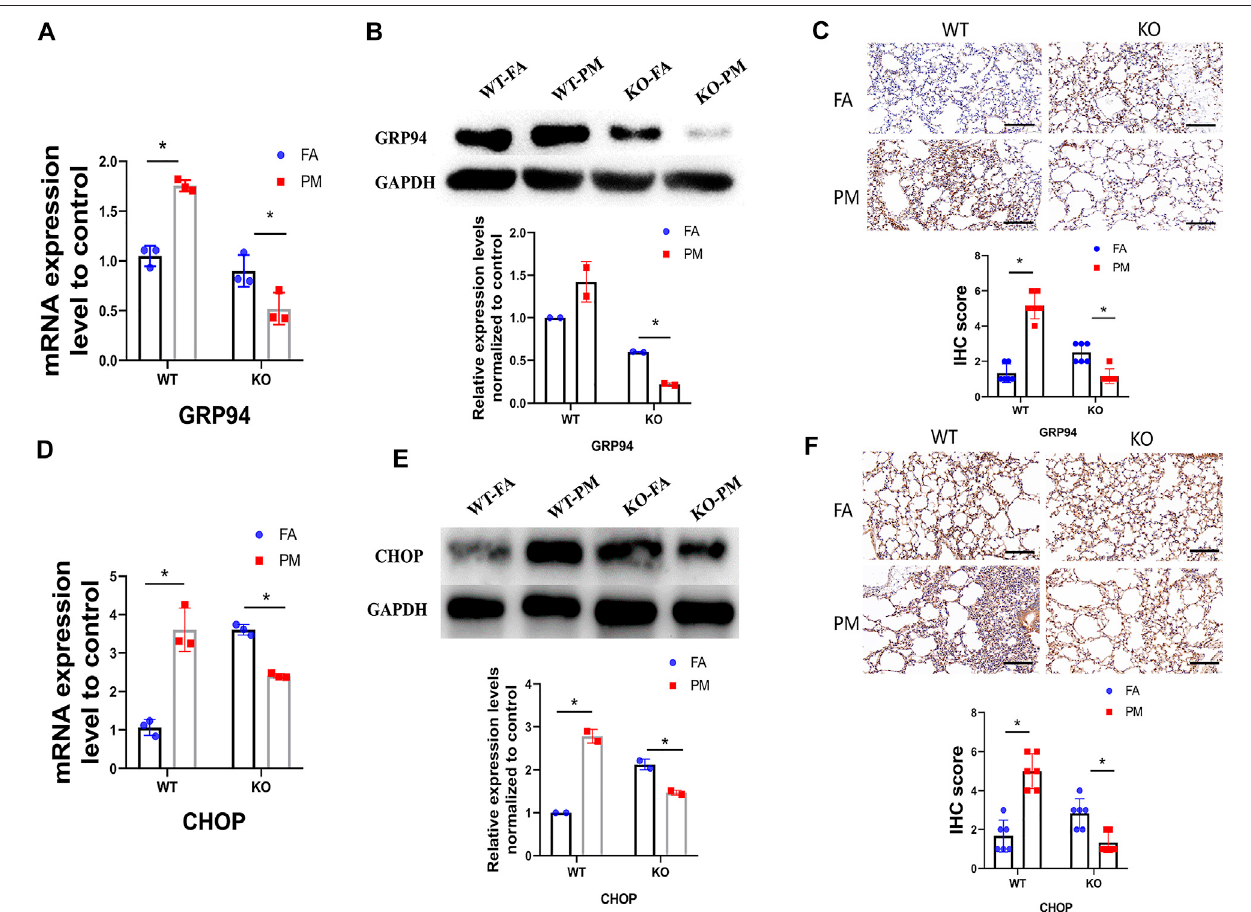
FIGURE 5 | The expression level of GRP94 and CHOP, biomarkers of ER stress. (A) Total RNA was extracted from lung tissues, and the mRNA levels of GRP94 was detected by QPCR. n (cid:2) 3 per group. (B) The GRP94 protein expression levels in four groups of mice were analyzed by Western blot and the quanti fi cation of the GRP94expression. n (cid:2) 2 per group. (C) Afterexposure, IHC stainingof GRP94 was performed in lung tissues, and the IHC score ofGRP94expression was calculated. n (cid:2) 3 per group. (D) The mRNA level of CHOP was detected by QPCR. n (cid:2) 3 per group. (E) The CHOP protein expression levels in four groups of mice were analyzedbyWesternblotandthequanti fi cationoftheCHOPexpression. n (cid:2) 2pergroup. (F) TheIHCstainingofCHOPwasperformedinlungtissuesandtheIHCscore of CHOP expression was calculated. n (cid:2) 3 per group. FA, fi ltered air; PM, fi ne particulate matter. WT, wild type mice; KO, Nrf2 − / − mice. Scale bars are 50 μ m, and magni fi cation is × 300. Data are expressed as the mean ± SEM, * p < 0.05.